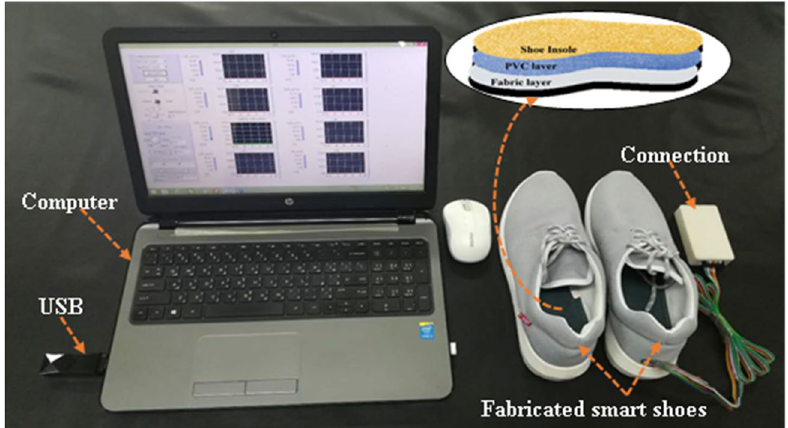
Figure 2. A complete plantar pressure monitoring system for analyzing body postures.